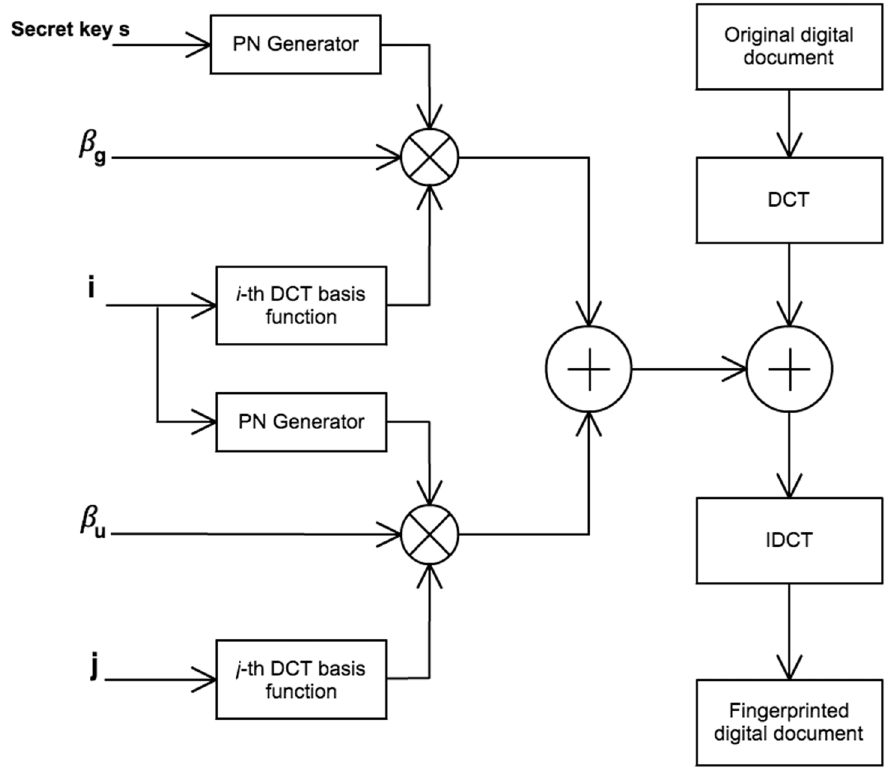
Figure 10. Diagram of fingerprint insertion method. doi:10.1371/journal.pone.0081976.g010 PLOS ONE |